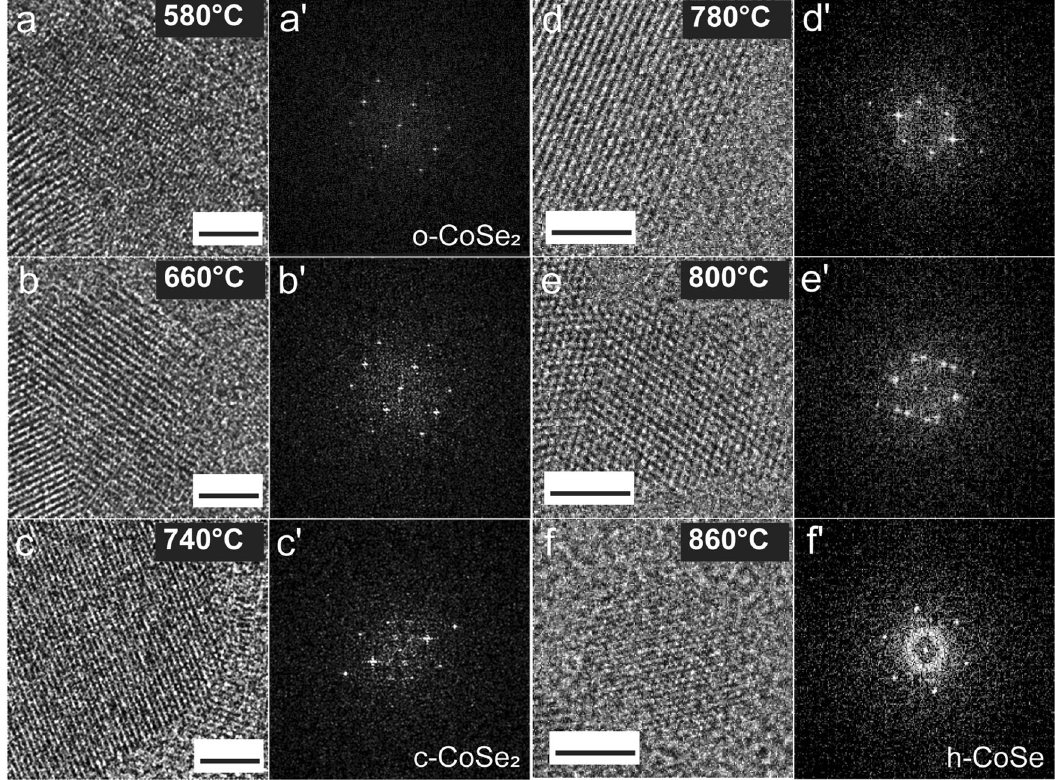
Fig. 2 HR-TEM images of structural transformations in o-CoSe 2 upon heating. a – f HR-TEM images captured during the structural transformations. a Area of o-CoSe 2 selected for in situ investigation, at a temperature of 580 °C. b Intermediate state at 660 °C showing a minor change in the o-CoSe 2 structure. c Cubic structure at 740 °C. d Transition state between c-CoSe 2 and hexagonal-CoSe at 780 °C. e Dynamical structural transformation at 800 °C. f Transformed h-CoSe at 860 °C. a ′ – f ′ Corresponding FFT patterns of respective HR-TEM images. The scale bars represent 2 nm. Crystallographic details and lattice parameters of the CoSe 2 and CoSe phases can be found in Supplementary Tables 2 and 3 of the